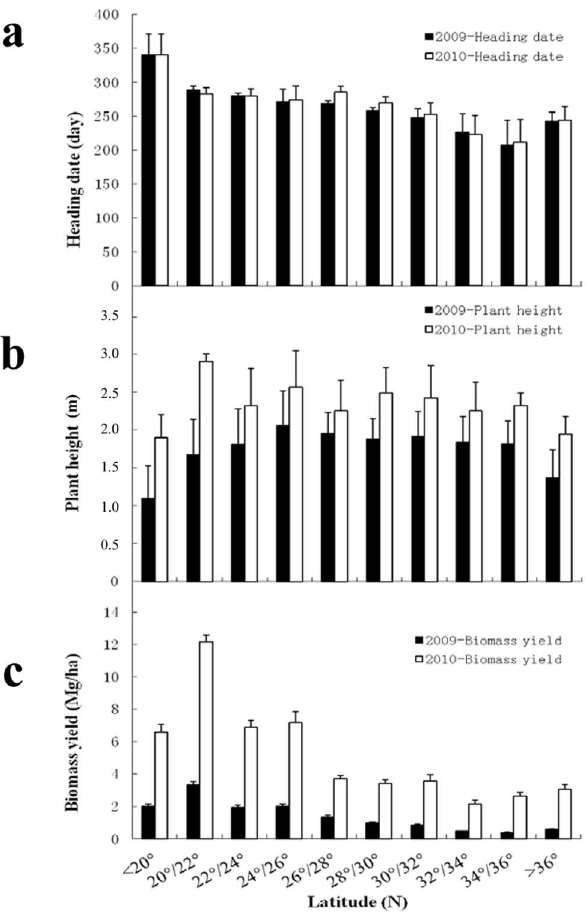
Figure 4. Phenotypic distribution against latitude (with interval of 2 u ) of the place of origin in Chinese M . sinensis germplasm. a) heading date, b) plant height and c) biomass yield in the 1 st (2009) and 2 nd (2010) year after the Miscanthus field was established.